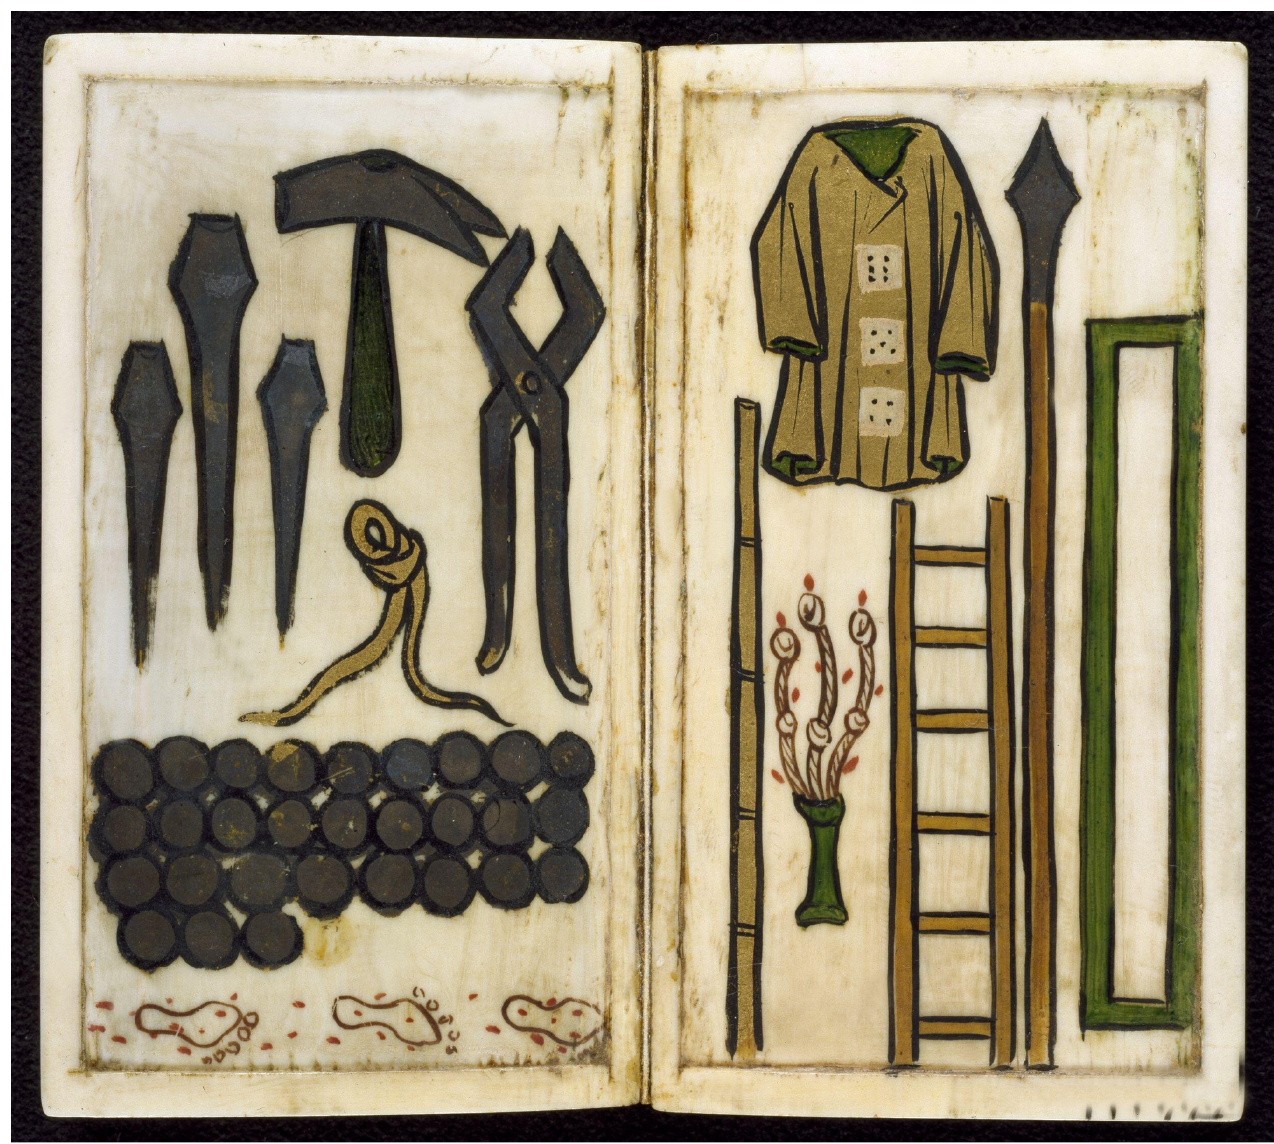
Figure 2. Devotional Booklet, c. 1330–1340. Victoria and Albert Museum (London). (Source: V&A Web, https://collections.vam.ac.uk/) (accessed on 18 July 2022).